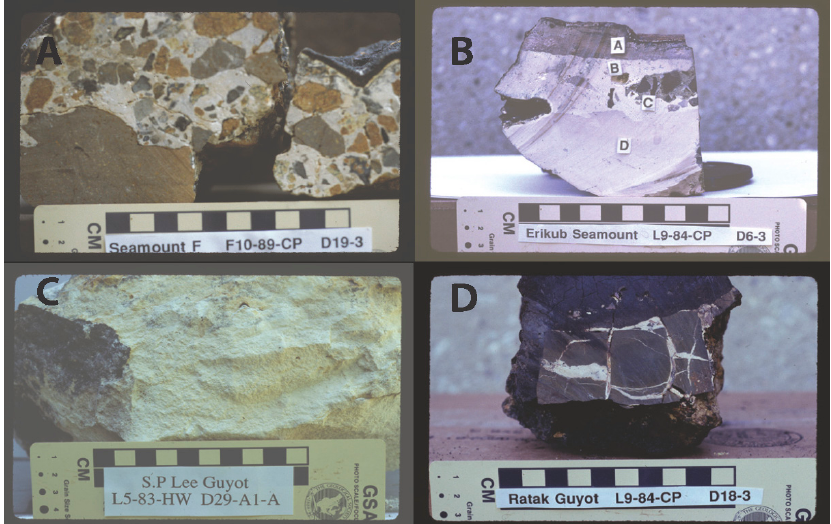
Figure 2. Photographs of seamount phosphorites: ( A ) cement-supported breccia; cement from carbonate fluorapatite (CFA)-replaced pelagic foraminifera matrix. ( B ) Massive, layered ( A – D ), recrystallized phosphorite; protolith cannot be distinguished, low porosity. ( C ) Massive bed of CFA-replaced foraminifera, with nearly pristine microfossil structure; minor rim cement on foraminifera indurates the rock; very high porosity. ( D ) CFA-replaced carbonate sand that filled fractures in basalt. Note Fe-Mn crust on at least one surface of each sample.